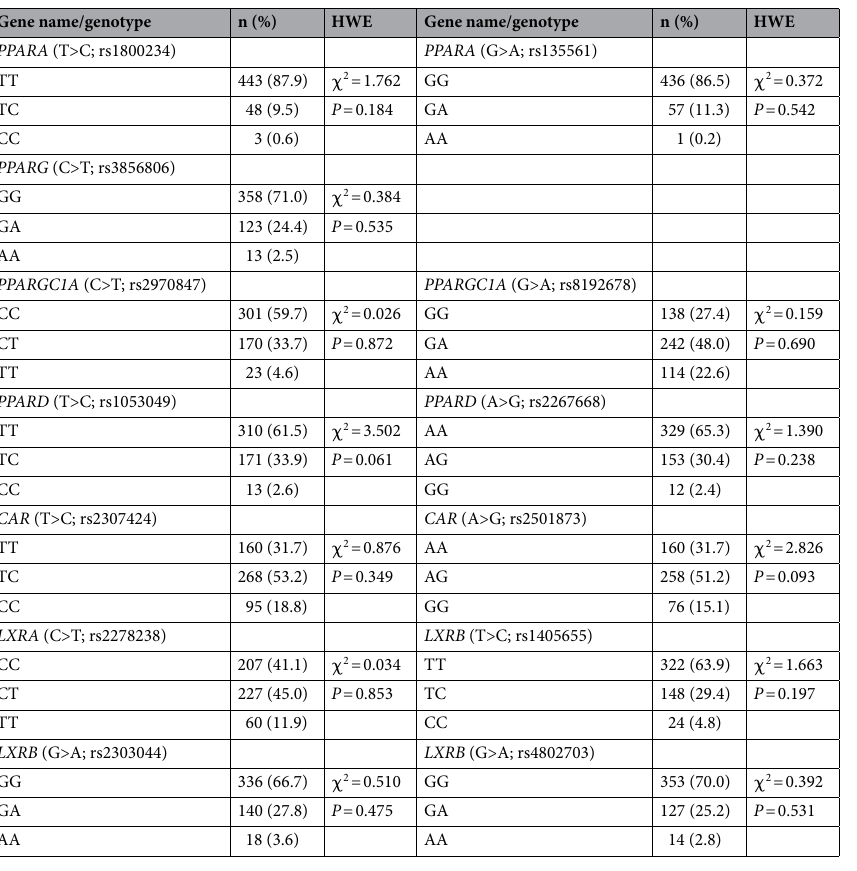
Table 2. Maternal genotype frequencies (n = 504). Ten mothers (2.0%) did not extract DNA and analyse genotypes due to a lack of maternal blood. Chi-square test was employed to test whether the frequency of genotype distribution conformed to the Hardy–Weinberg equilibrium. CAR, constitutive androstane receptor; HWE, Hardy–Weinberg equilibrium; LXRA, liver X receptor alpha; LXRB, liver X receptor beta; PPARA, peroxisome proliferator-activated receptor alpha; PPARD, peroxisome proliferator-activated receptor delta; PPARG, peroxisome proliferator-activated receptor gamma; PPARGC1A, peroxisome proliferator-activated receptor gamma co-activator